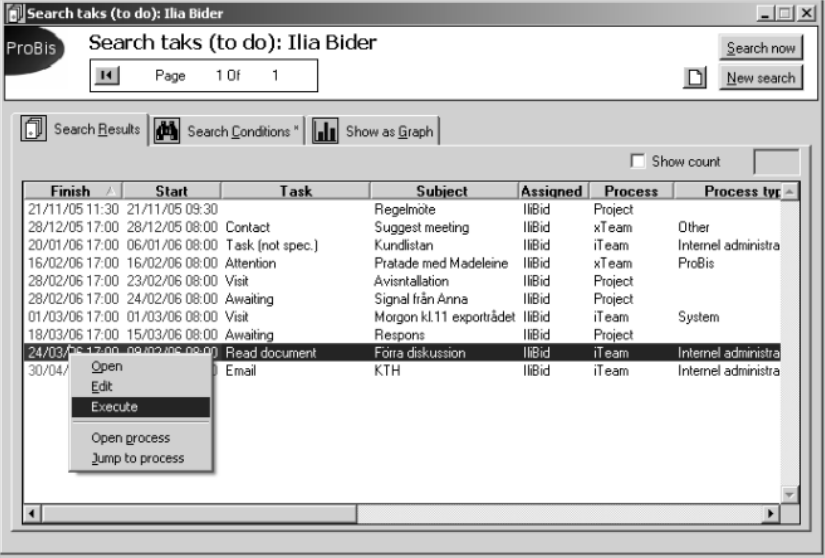
Figure 6. A person’s calendar serves as a mechanism for inviting him/her to visit shared